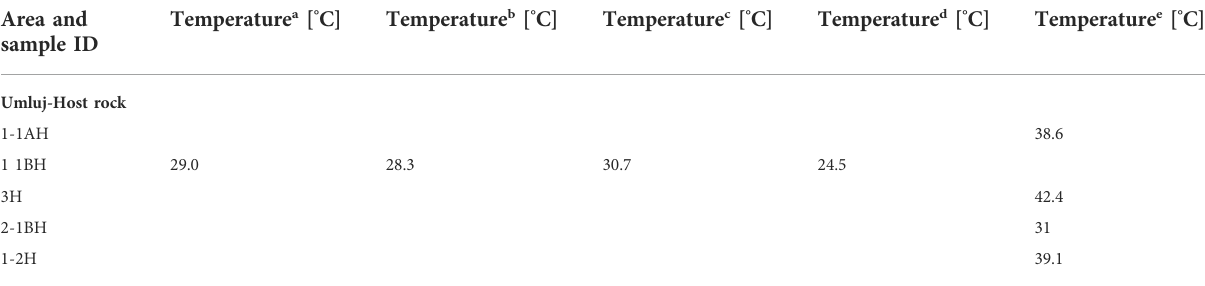
TABLE 2 Calculated paleotemperature of host rock